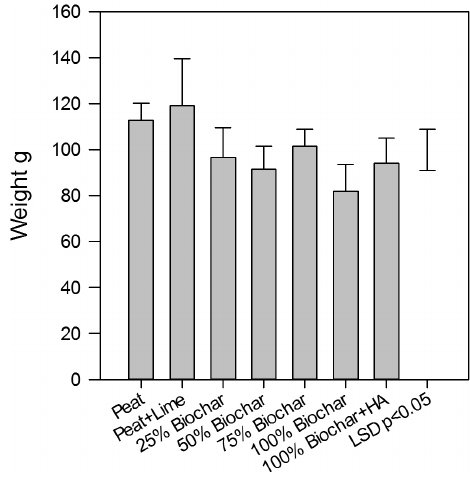
Figure 4. Fresh weight of miniature sunflowers grown in peat, limed peat, biochar and biochar–peat mixtures in leachate 6 weeks after planting ( n = 4, means and standard deviation, HA: humid acid, leonardite, LSD: least significant